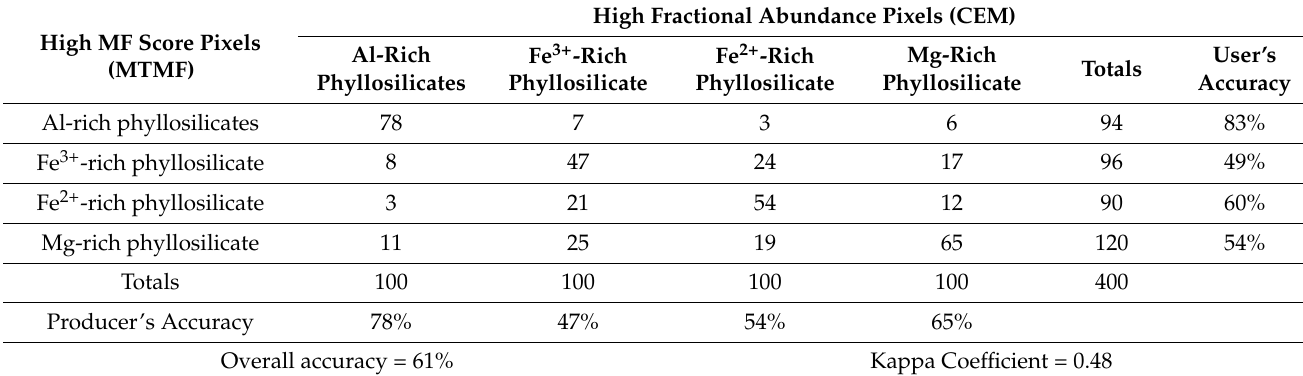
Table 3. Error matrix for the MF score images versus the CEM fraction images derived from VNIR+SWIR bands of ASTER.